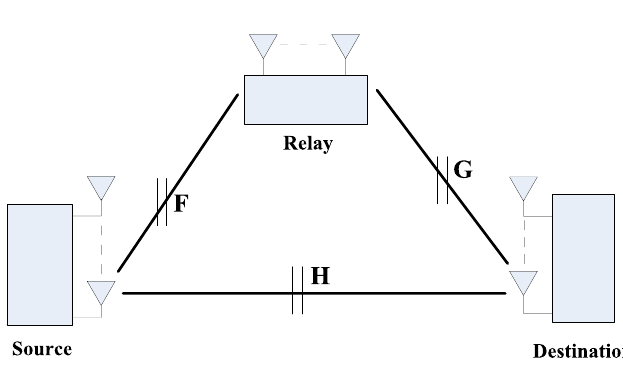
Figure 1. MIMO relay